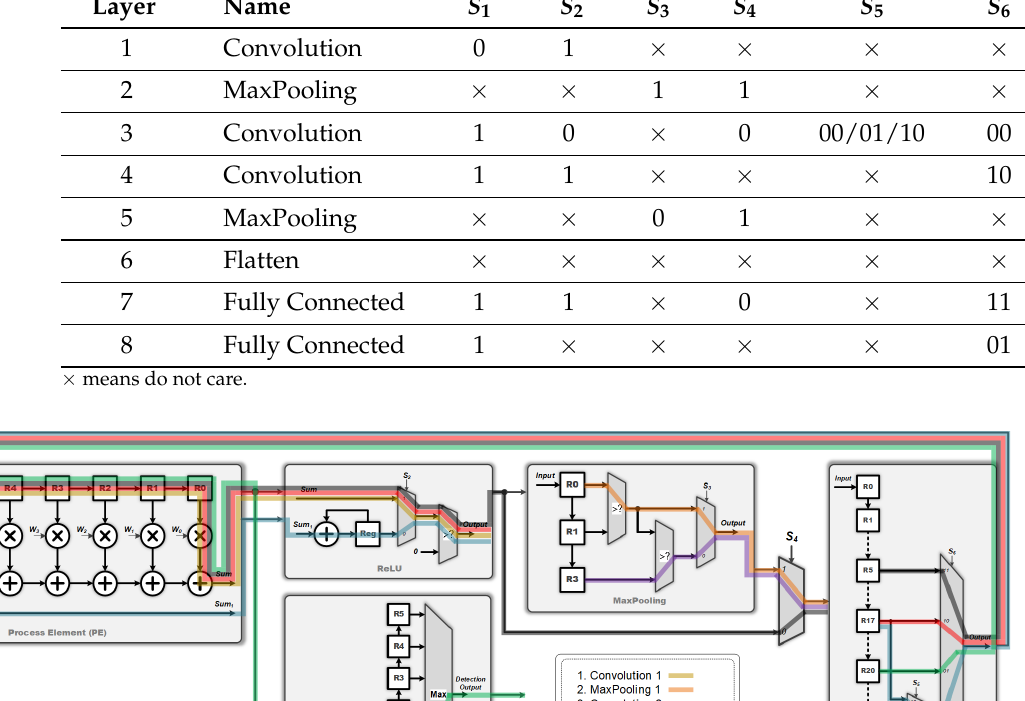
Figure 9. The layout (left) and photomicrograph (right) of the proposed CNN accelerator.